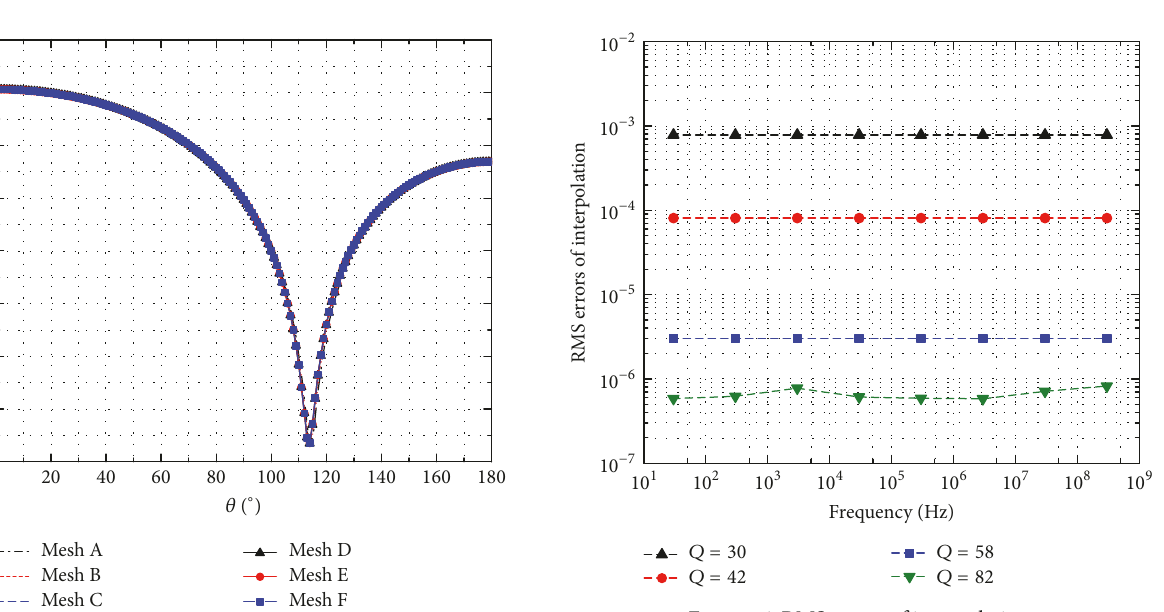
Figure 4: Bistatic RCS of the PEC cube with different meshes.